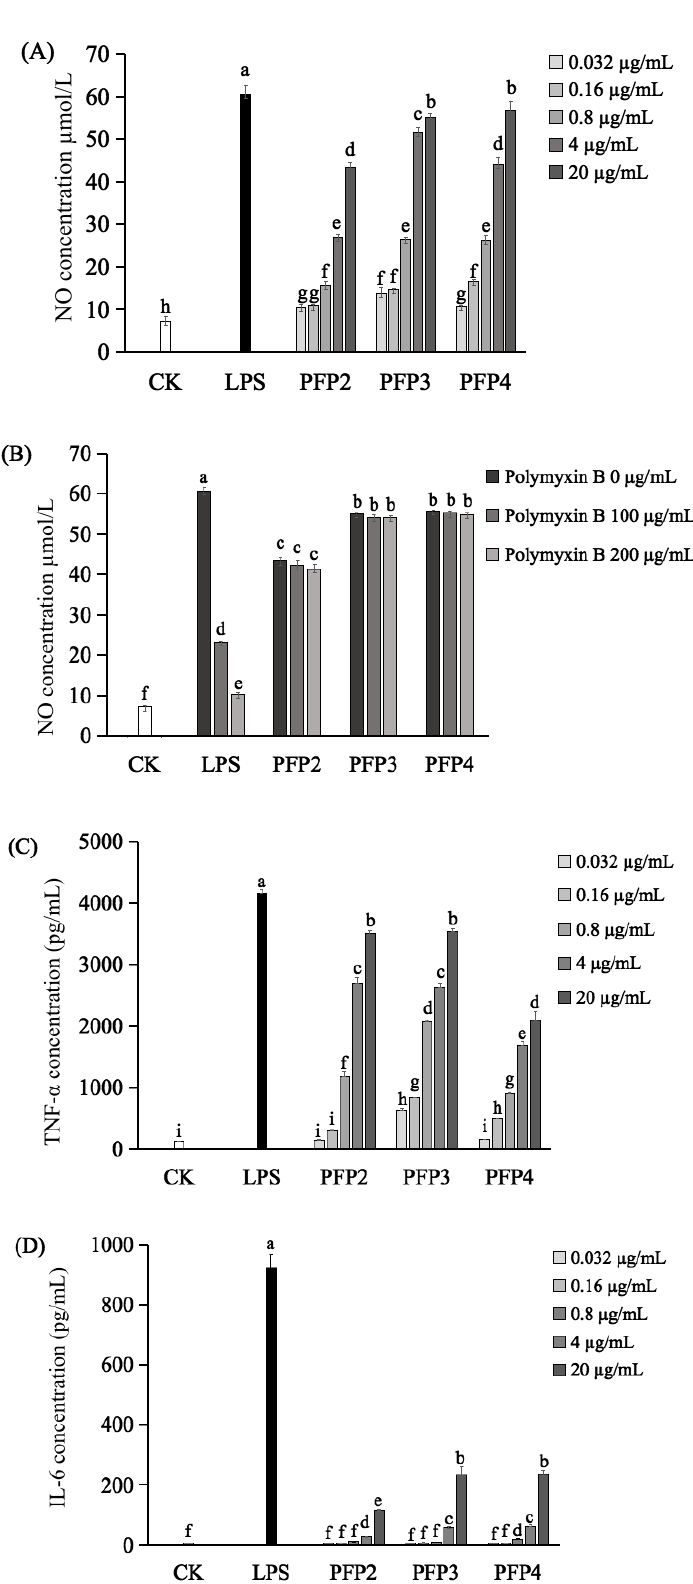
Figure 4. NO release detection of RAW264.7 cell activation. By LPS, PFP2, PFP3, and PFP4 ( A ). By LPS, PFP2, PFP3, and PFP4 with polymyxin B ( B ). Elisa detection of tumor necrosis factor- α (TNF- α ) ( C ) and interleukin-6 (IL-6) ( D ). Data were presented as mean ± SD. Di ff erent lowercase alphabet letters (a–i) were significantly di ff erent if p <